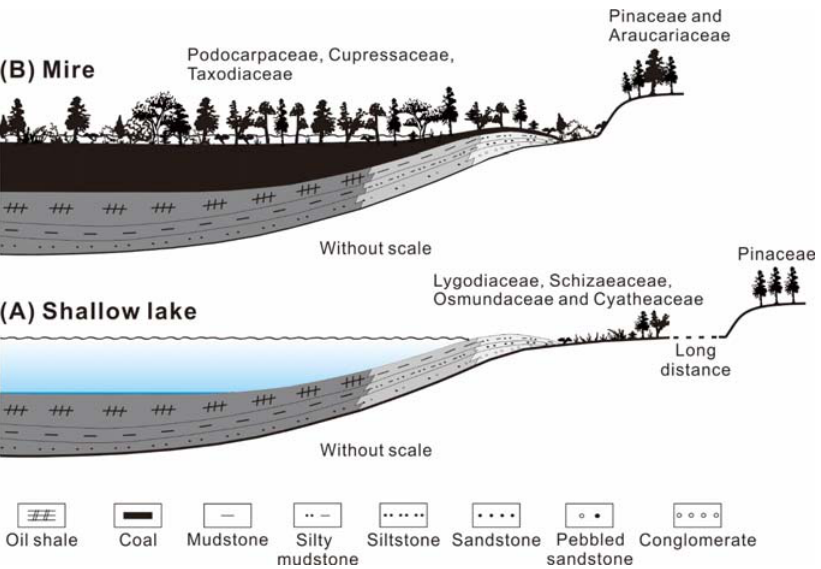
Figure 14. Diagram illustrating the paleoenvironment and paleovegetation during the formation of ( A ) oil shale and ( B ) coal. ( A ) oil shale and ( B )